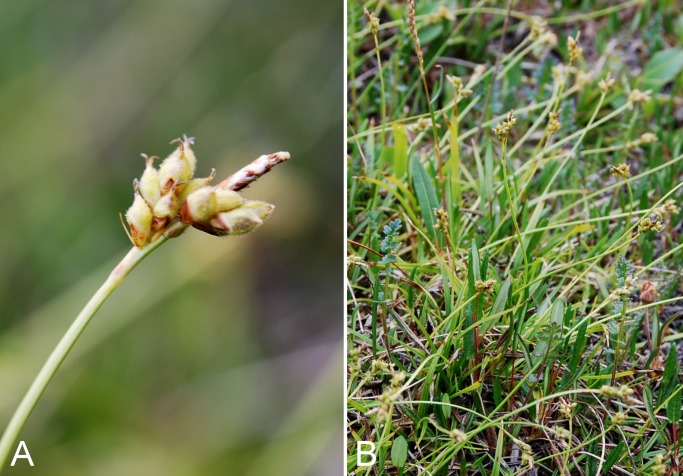
Carex concinna.(A) Inflorescence, Saarela et al. 3567. (B) Habit, Saarela et al. 3569. Photographs by J. M. Saarela.